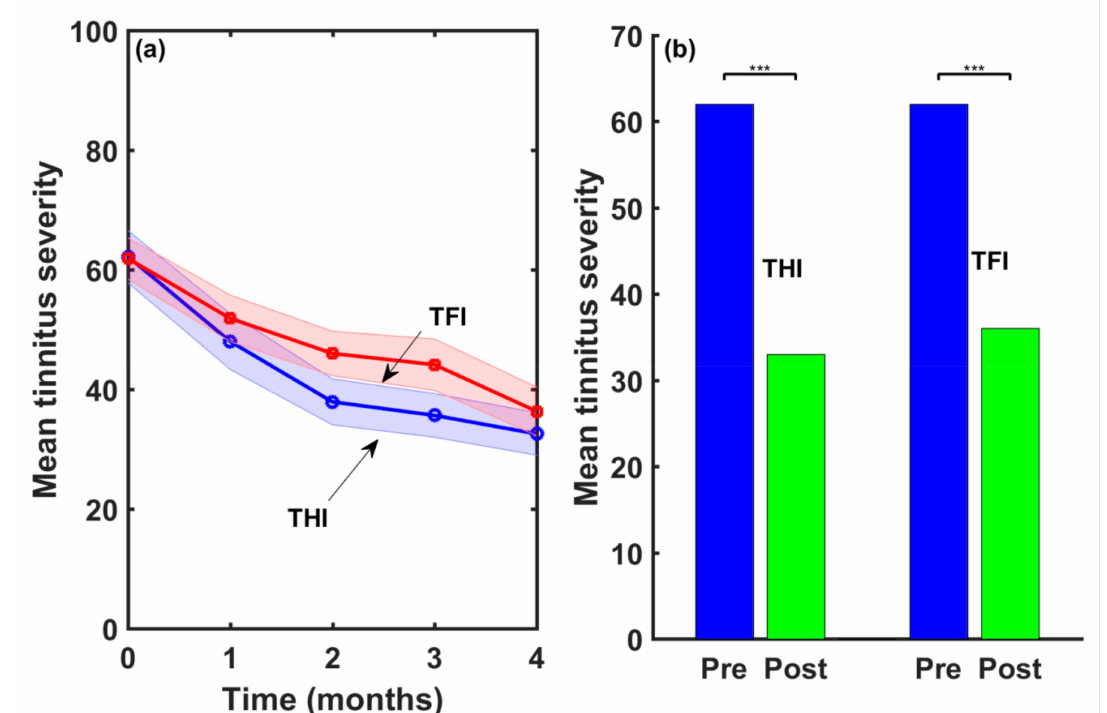
Figure 5. ( a ) Tinnitus severity reduction following the four-month treatment and ( b ) result of the application of the ANOVA